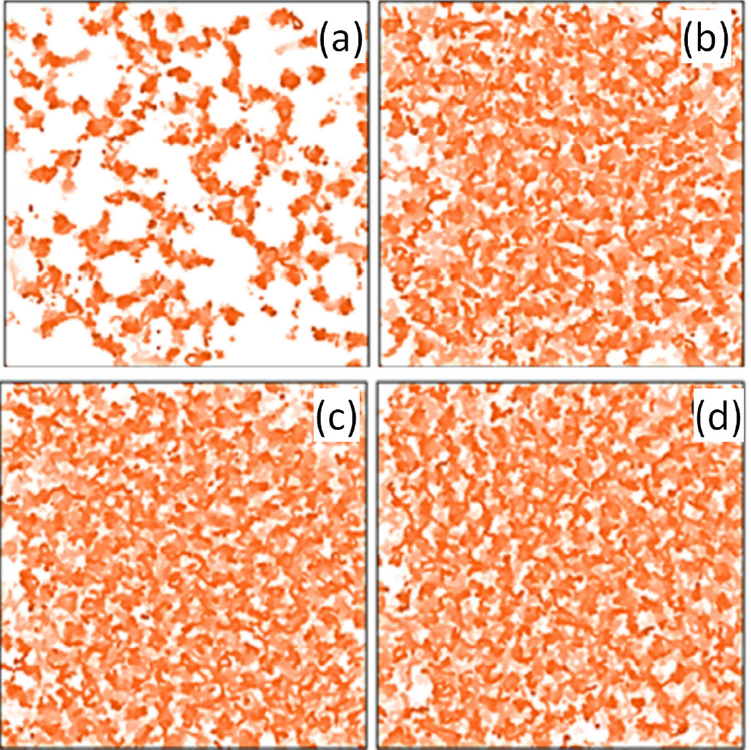
Figure 16. Atomic ordering at the interface of liquid/bulk amorphous substrate [25]. The time-averaged atomic positions of ( a ) L1, ( b ) L2, ( c ) L3, and ( d ) L4 in the liquid Al adjacent to the bulk amorphous substrate equilibrated at 1000 K. The atoms in the liquid at the interface exhibit a completely disordered structure. (Reprinted with permission from Ref. [25]. Copyright 2022, Elsevier.)